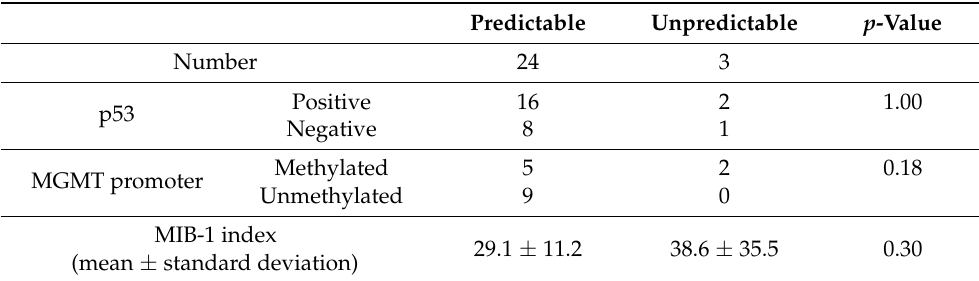
Table 4. The status of p53, MGMT promoter, and MIB-1 index in predictable and unpredictable glioblastoma, IDH-wildtype